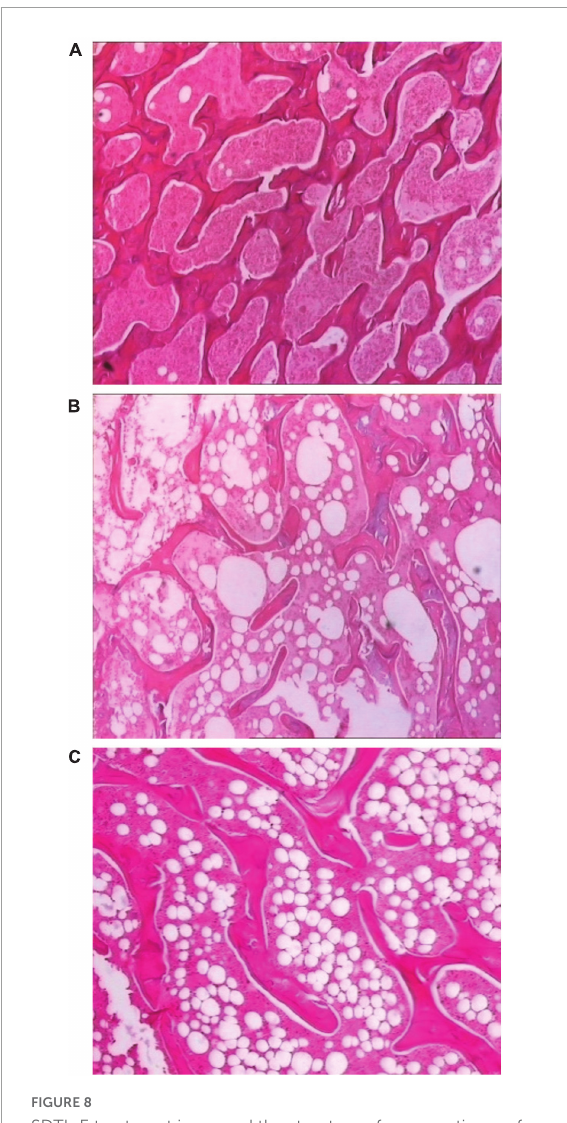
FIGURE8 SDTL-E treatment improved the structure of osseous tissue of OVX-induced osteoporosis rats. Model Group and Control Group rats were treated with vegetable oil. SDTL-E Group rats were treated with SDTL-E. All treatments were topically applied twice daily for 20 days. Osseous tissues of left femur were stained by hematoxylin and eosin, followed by observation under light microscope with 200X magnification. Above are representative staining images of (A) Control Group (B) Model Group and (C) SDTL-E Group